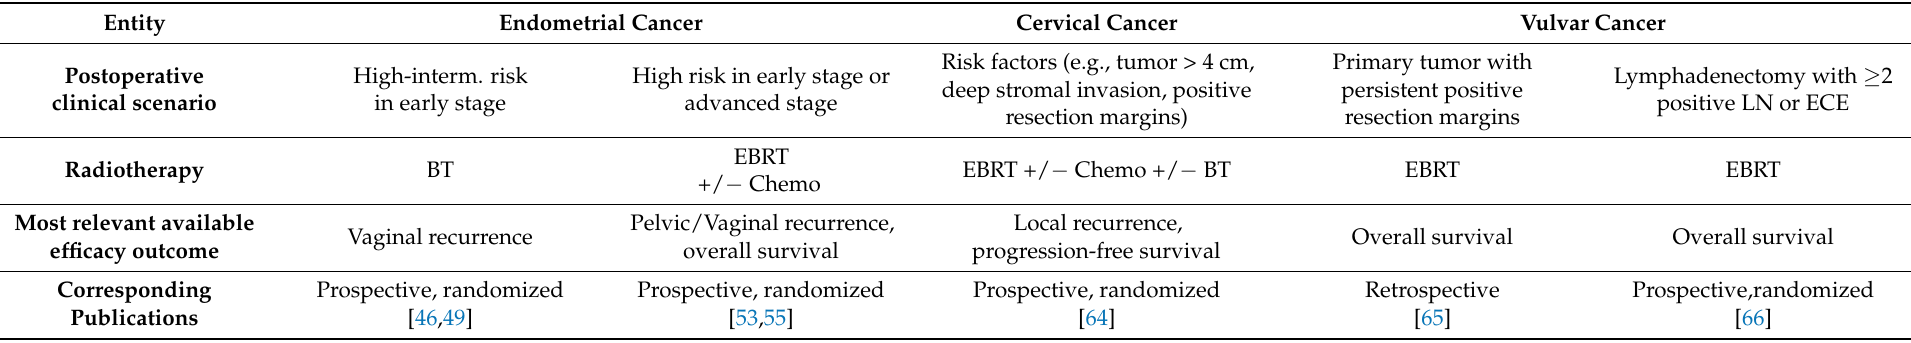
Table 1. Schematic overview of common indications for adjuvant radiotherapy in newly diagnosed localized gynecological malignancies. Adjuvant radiotherapy is not used for ovarian cancer. The approach to vaginal cancer is similar to that for cervical cancer. Ovarian and vaginal cancer are therefore not listed here.